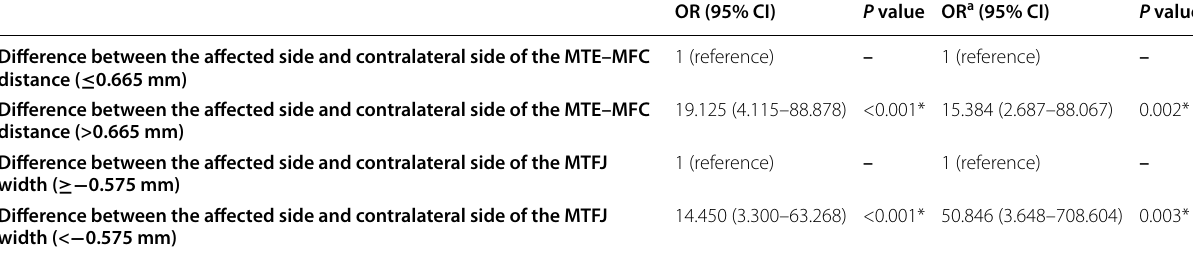
Note : ORs and 95% CI for MMPRT by X-ray measurements Abbreviations : MTE medial tibial eminence, MFC medial femoral condyle, MTFJ medial tibial femoral joint, MMPRT medial meniscus posterior root tear, OR Odds ratio, CI confidence interval a Adjusted for age, body mass index, and posterior tibial slope. * P <